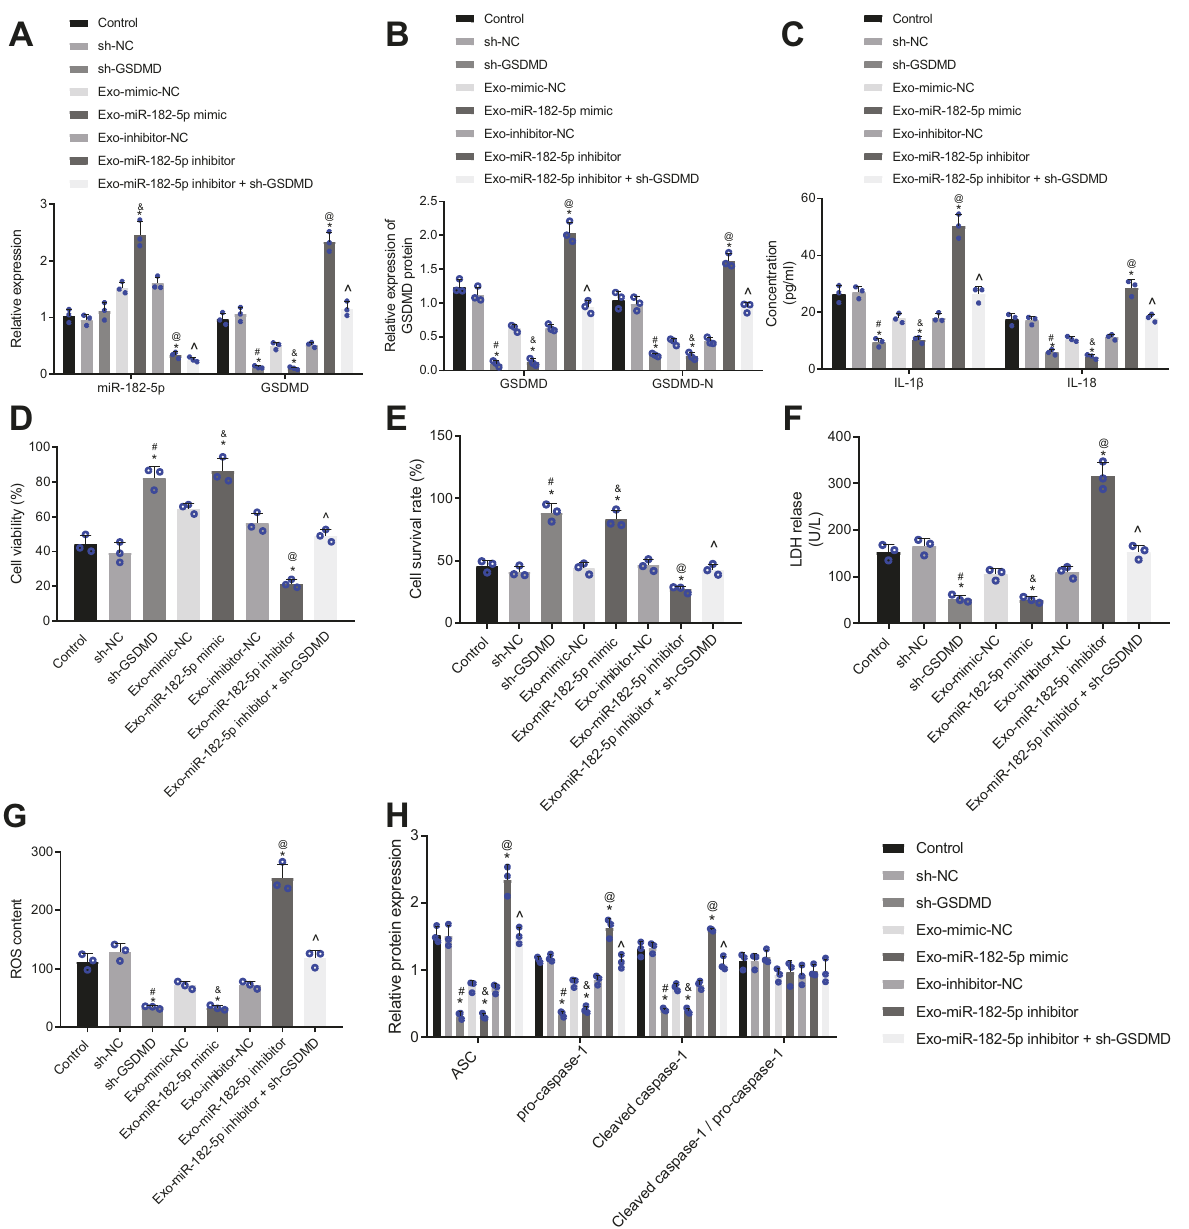
Fig. 6 Exosomal miR-182-5p from MSCs inhibits in fl ammation and pyroptosis of H/R-exposed myocardial cells via inhibition of GSDMD. H/R-exposed myocardial cells were co-cultured with MSC-derived exosomes or not. GSDMD expression was silenced in H/R-exposed myocardial cells while miR-182-5p expression was altered in MSC-derived exosomes using mimics or inhibitors before co-culture. A miR-182-5p expression and GSDMD mRNA level in H/R-exposed myocardial cells detected by RT-qPCR, normalized to U6 and GAPDH, respectively; B Western blot analysis of GSDMD protein and GSDMD N in H/R-exposed myocardial cells, normalized to GAPDH; C The levels of IL-1 β and IL-18 in the supernatant of H/R- exposed myocardial cells determined by ELISA; D The viability of H/R-exposed myocardial cells assessed by Calcein-AM/PI double staining; E The survival rate of H/R-exposed myocardial cells measured by trypan blue staining; F LDH release in H/R-exposed myocardial cells detected by LDH kit; G ROS production in H/R-exposed myocardial cells examined by DCFH-DA; H Western blot analysis of ASC, pro-caspase-1, and caspase-1 proteins as well as the cleaved caspase-1/pro-caspase-1 ratio in H/R-exposed myocardial cells, normalized to GAPDH. Measurement data were expressed as mean ±standard deviation. The comparison among multiple groups was conducted with one-way ANOVA, followed by Tukey ’ s post hoc test. Each cell experiment was repeated three times independently. * P <0.05 vs. H/R-exposed myocardial cells without transfection, # P <0.05 vs. H/R-exposed myocardial cells transfected with sh-NC and co-cultured with exosomes, & P <0.05 vs. H/R-exposed myocardial cells co-cultured with exo-mimic-NC, @ P <0.05 vs. H/R-exposed myocardial cells co-cultured with exo-inhibitor-NC, ^ P <0.05 vs. H/R-exposed myocardial cells transfected with